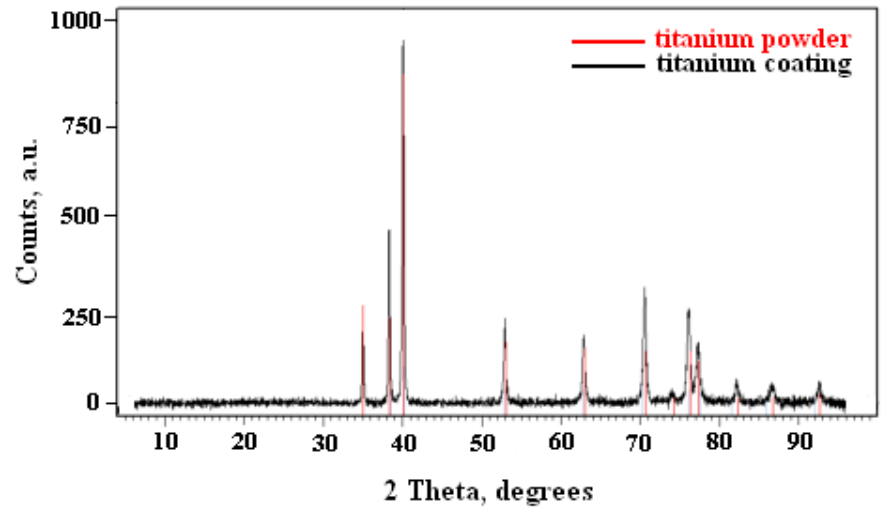
Figure 4. X-ray spectrum of cold sprayed titanium coating onto Al7075 substrate deposited at SoD of 70 mm.